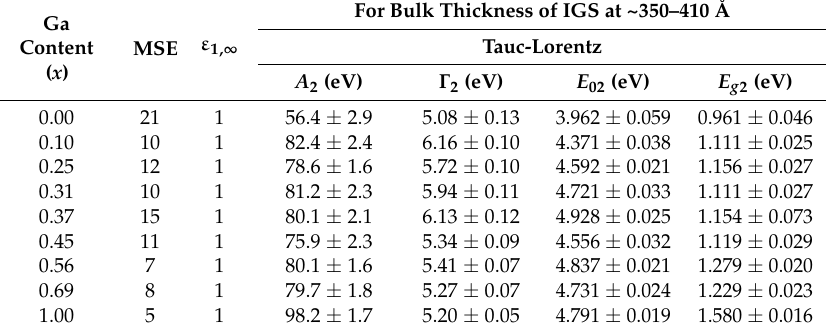
Table 7. Compositions, best fit mean square errors (MSE), along with fixed and variable parameters in the single Tauc-Lorentz (TL) oscillator expressions that define the ( ε 1 , ε 2 ) spectra at a measurement temperature of 400 ◦ C for ~350–410 Å thick IGS films with different Ga contents x . One of the five possible variable parameters of the TL expression, ε 1, ∞ , is fixed at 1 in the best fit analyses, as shown in the third